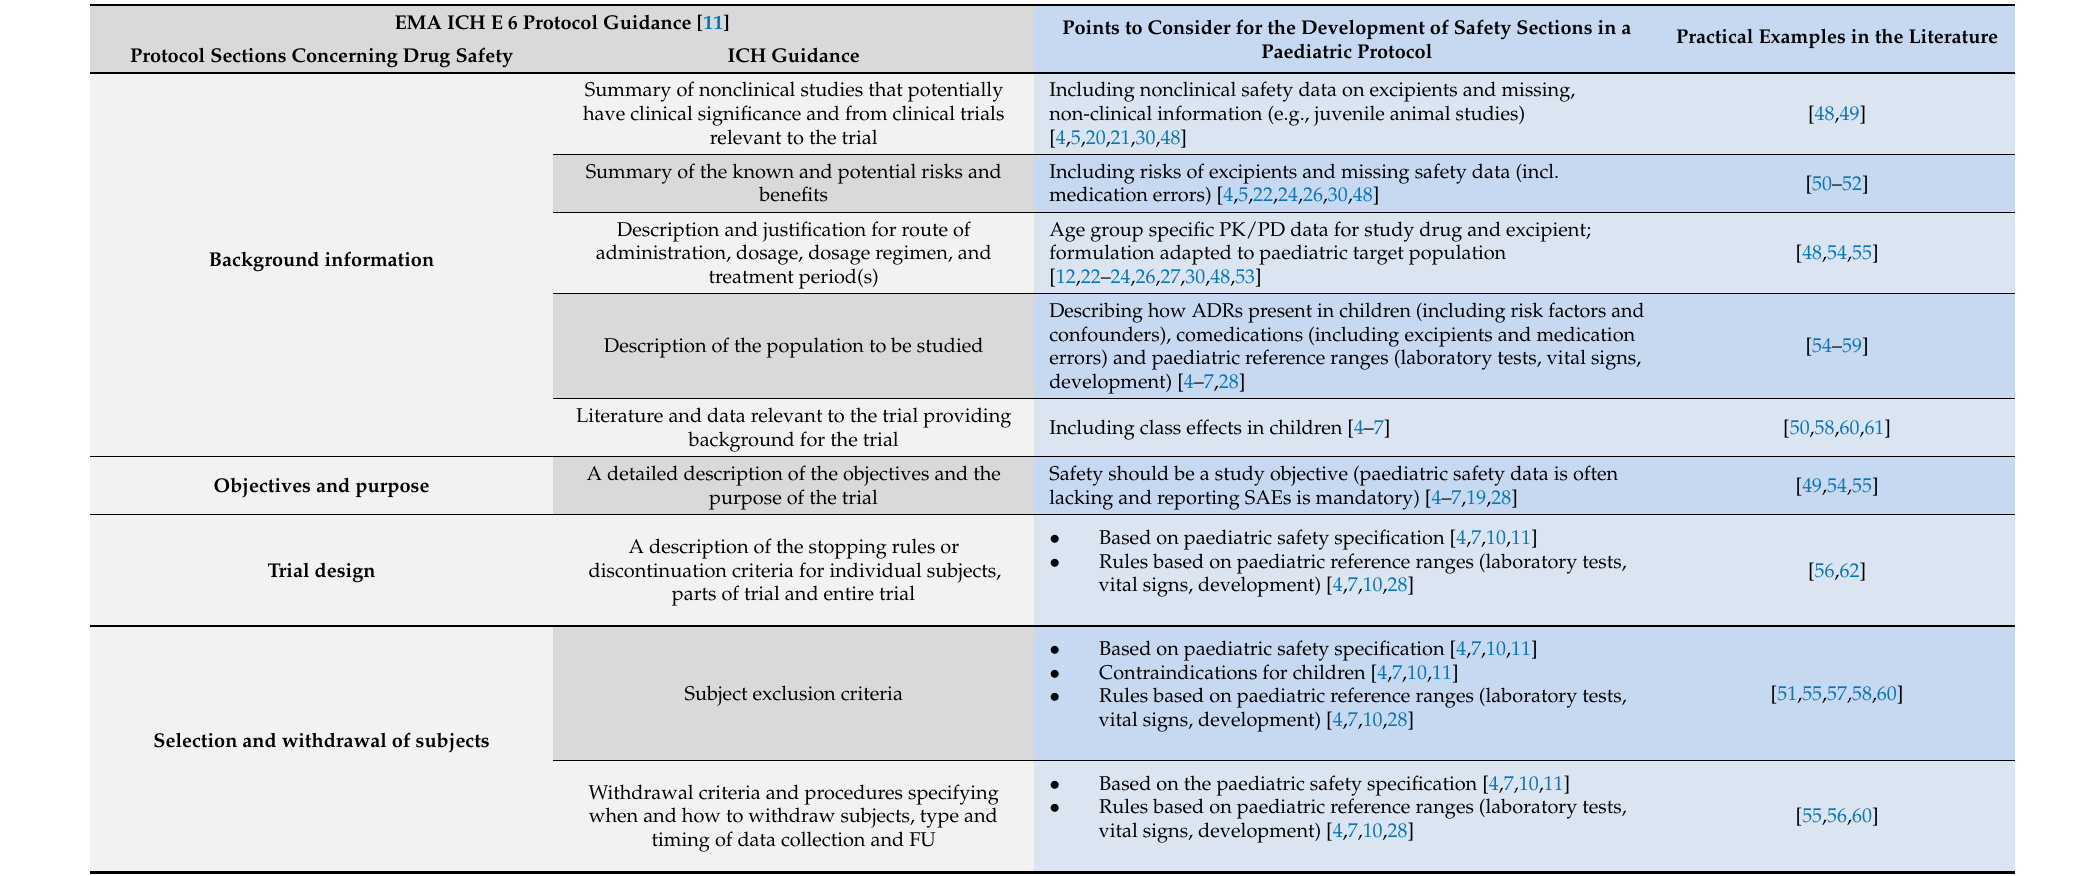
Table 2. EMA ICH E6 Protocol Guidance: Examples of the paediatric safety specification informing paediatric protocol